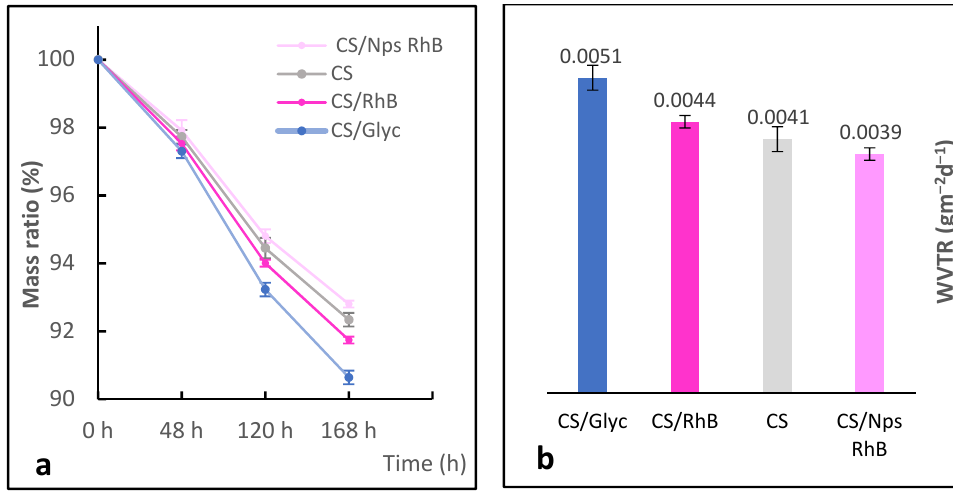
Figure 6. Diffusion of water vapour through the film. Changes in the sample masses as a function of time ( a ) and the water vapour transmission rate (WVTR) ( b ).